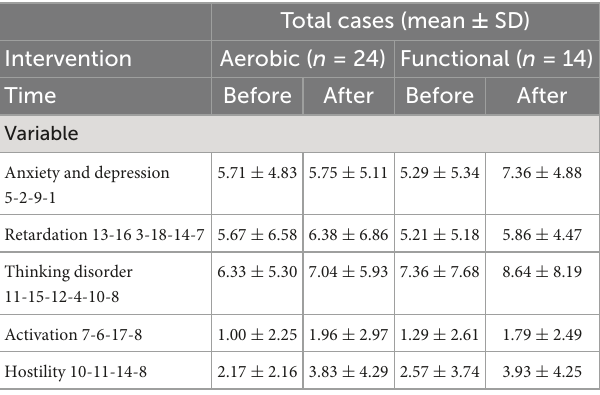
TABLE 2 BPRS values in patients according to